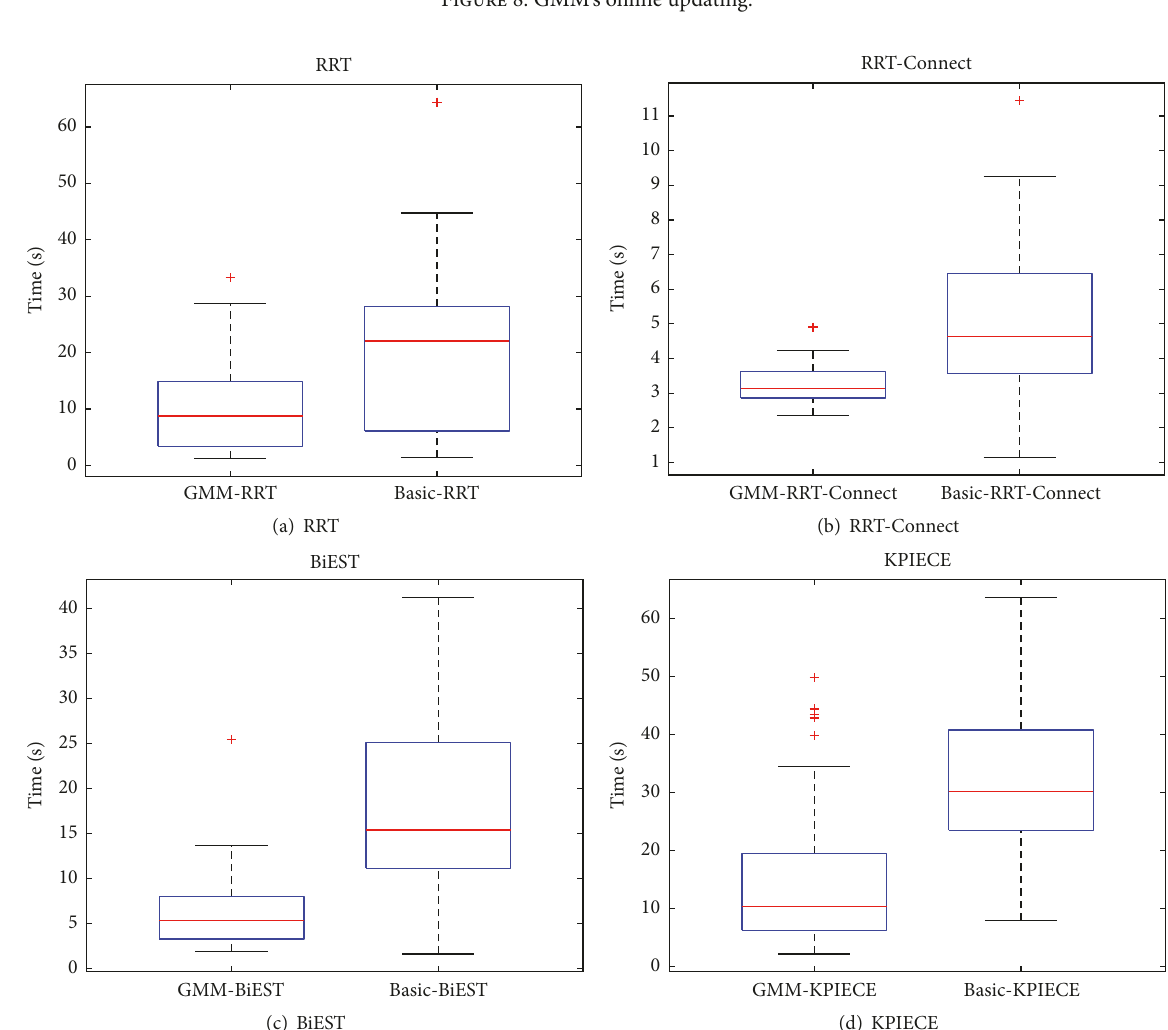
Figure 9: The boxplots of various motion planning algorithms’ planning